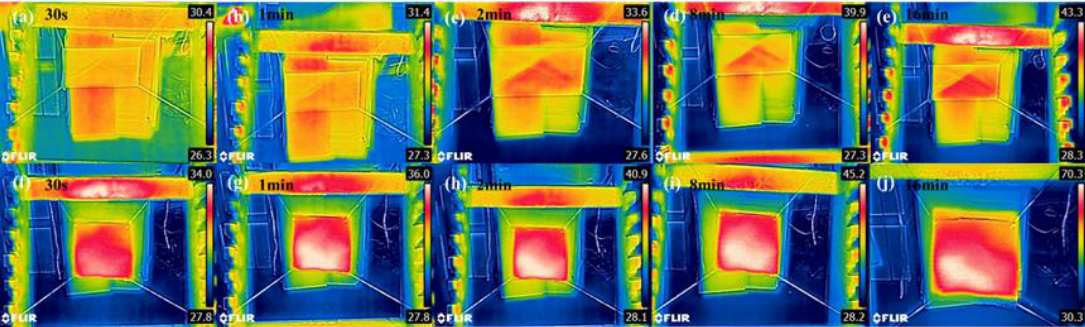
Figure 12. Thermal infrared image of PET after short-term ultraviolet radiation of PET fabrics ( a – e ) and CA-Fe-SH-PET fabric ( f – j ).